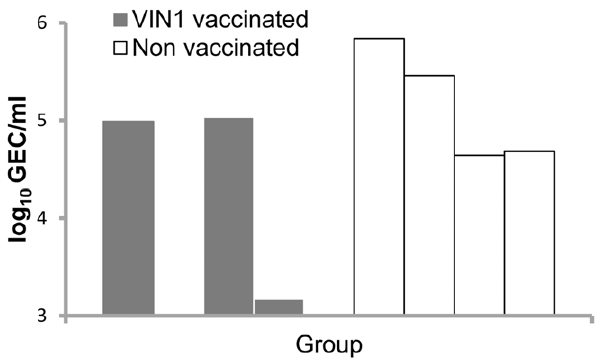
Figure 3. Immunization with VIN1-HA1 partially protects pigs invivo against heterologous challenge with pH1N1. Influenza viral RNA quantification in BAL was performed by RT-qPCR at 6 dpi, corresponding to necropsy day. Bars indicated positive samples in genome equivalent copies (GEC) per ml of BAL. The detection limit in the assay was 3 log 10 GEC/ml.